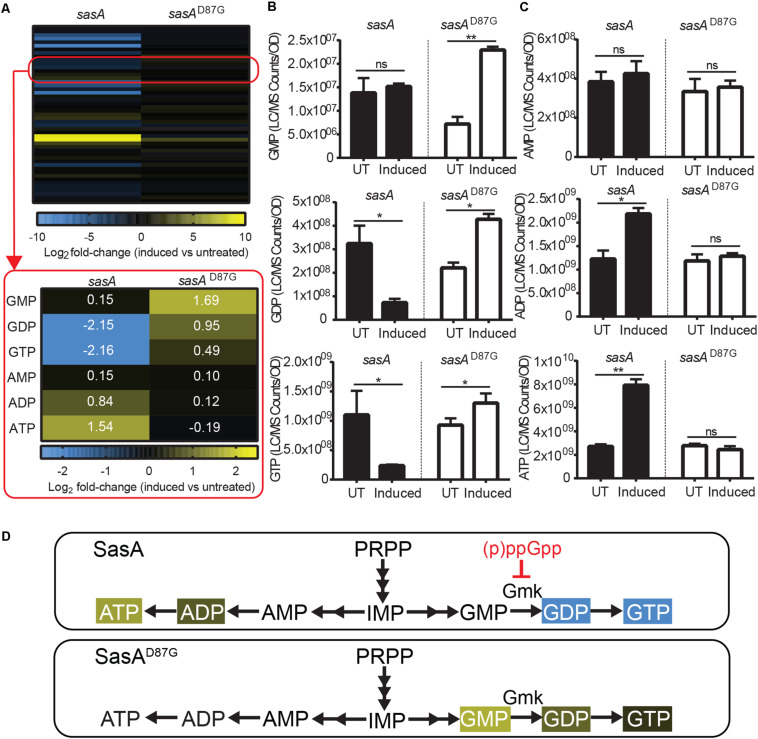
Expression of SasA leads to depletion of guanine nucleotides and accumulation of adenine nucleotides. (A) Heat map of metabolite changes in cells after sasA or sasAD87G expression. Red box highlights the changes in the level of guanine and adenine nucleotides. GMP, Guanosine monophosphate; GDP, Guanosine diphosphate; GTP, Guanosine triphosphate; AMP, Adenosine monophosphate; ADP, Adenosine diphosphate; ATP, Adenosine triphosphate. Numbers indicate mean fold-change in binary logarithm relative to untreated cells. (B) Levels of GMP, GDP, and GTP in cells before and after sasA or sasAD87G expression. (C) Levels of AMP, ADP, and ATP in cells before and after sasA or sasAD87G expression. UT: untreated, Induced: after induction. Data shown are LC-MS ion counts normalized to OD600. Error bars indicate SD. n = 2. **p < 0.01, *p < 0.05, ns, not significant (Student’s t-test). (D) Summary of nucleotide changes in cells expressing sasA or sasAD87G. Color-shaded are metabolites with log2 fold-change ≥ 0.5 (yellow) or = −0.5 (blue) as shown in (A). Red blunt arrow indicates direct inhibition by (p)ppGpp. Gmk: Guanylate kinase.